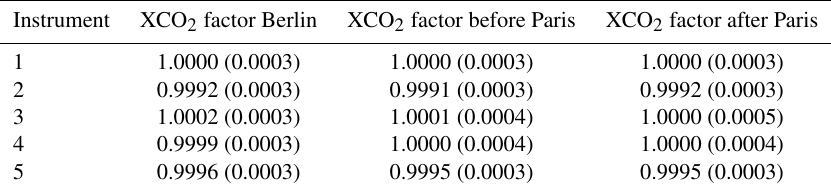
Table 1. Normalization factors for the five EM27/SUN instruments derived during measurements before and after the Paris field campaign. Values in parentheses are standard deviations. Measurements of instrument 1 were arbitrarily chosen as the reference from which the others were scaled. The calibration factors from a previous field campaign in Berlin (Hase et al., 2015) are also shown. Calibration factors between the two field campaigns agree well within 0.02% ( ∼ 0 . 08ppm) for all